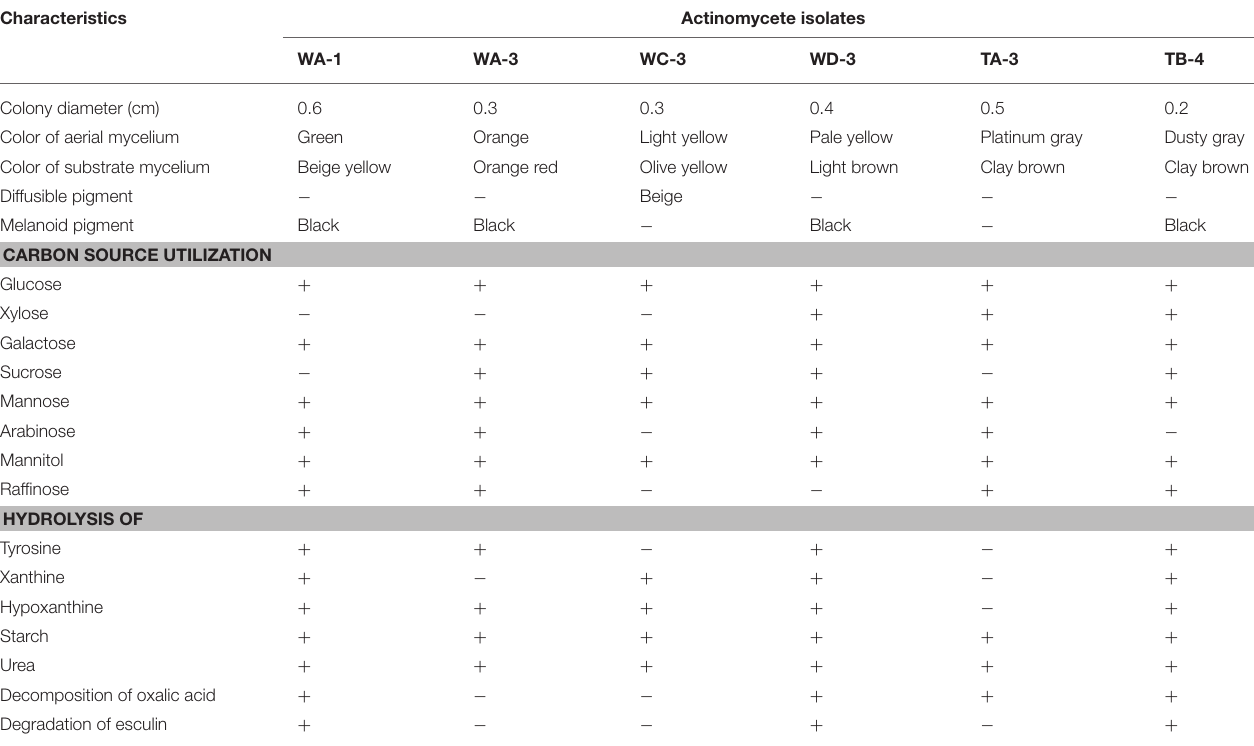
TABLE 1 | Morphological, biochemical, and physiological characteristics of the selected rhizospheric actinomycete strains. Characteristics